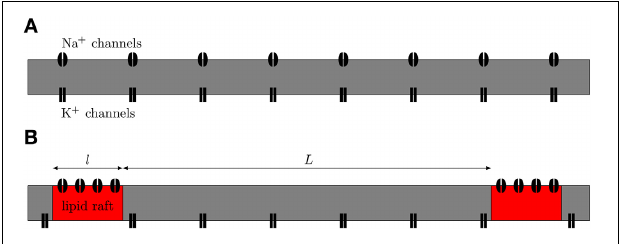
FIGURE 1 | Schematic view of axonal models. (A) The null-hypothesis axon. Both Na + and K + channels are uniformly diffused along the axon. (B) Axon with Na + channels clustered together on lipid rafts. We model this axon by placing a compartment containing a high density of Na + channels at regular distances in between compartments containing only K +